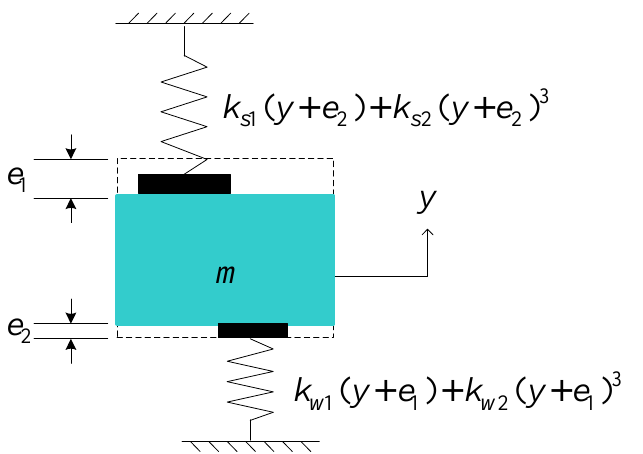
Figure 3. Piecewise nonlinear spring force model of hot rolling mill rolls in the vertical vibration direction.